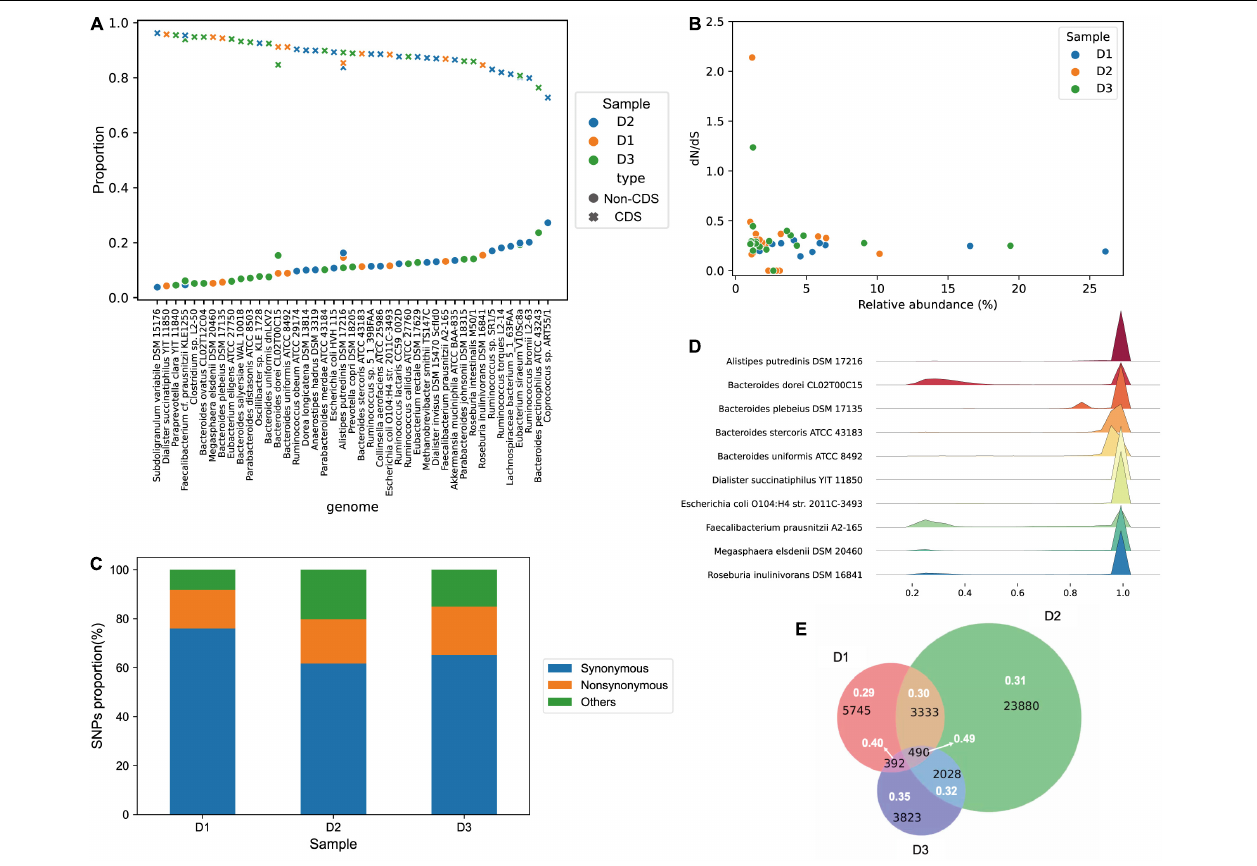
FIGURE 3 | SNP function profiles of dominant strains in ultra-deep sequencing samples. (A) Proportions of the CDS-SNPs and the non-CDS-SNPs in each sample. For each dominant strain in samples, the proportion of the CDS-SNPs represents the proportion of SNPs located in the coding region, and the proportion of the non-CDS-SNPs represents the proportion of SNPs located in the non-coding region. (B) Relationships between the dN/dS ratio and relative abundances of dominant strains in each sample. The dN/dS ratio equals the number of non-synonymous SNPs divided by the number of synonymous SNPs. (C) Proportions of different types of the cumulative SNPs from all dominant strains in the ultra-deep sequencing samples. (D) Allele frequencies of SNPs of dominant strains in sample D1. The X -axis represents the allele frequencies of SNPs, and Y -axis shows the name of dominant strains. (E) Venn diagrams of SNPs of strain Alistipes putredinis DSM 17216 in the three samples. Black numbers represent the number of SNPs, and white numbers represent the dN/dS ratio of these